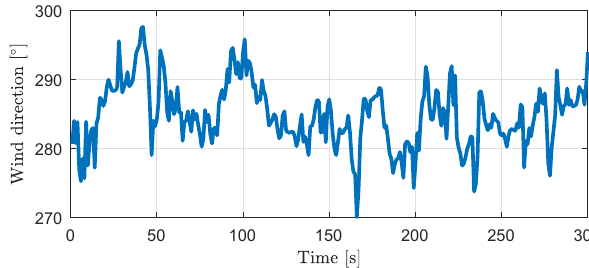
Figure 2. Exemplary 5min time series of wind direction measure- ments recorded at an onshore test site in northern Germany sampled at 1Hz